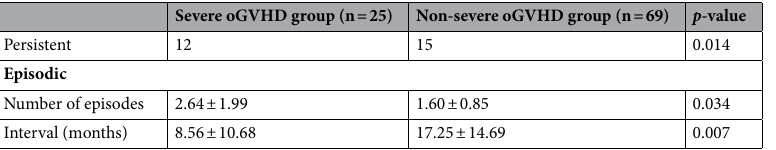
Table 3. Pattern of disease activity during follow-up periods in the severe and non-severe ocular graft-versus- host disease (GVHD) groups. oGVHD Ocular graft-versus-host